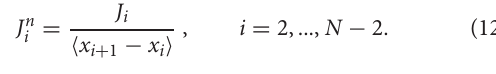
J i defined by Equation h i